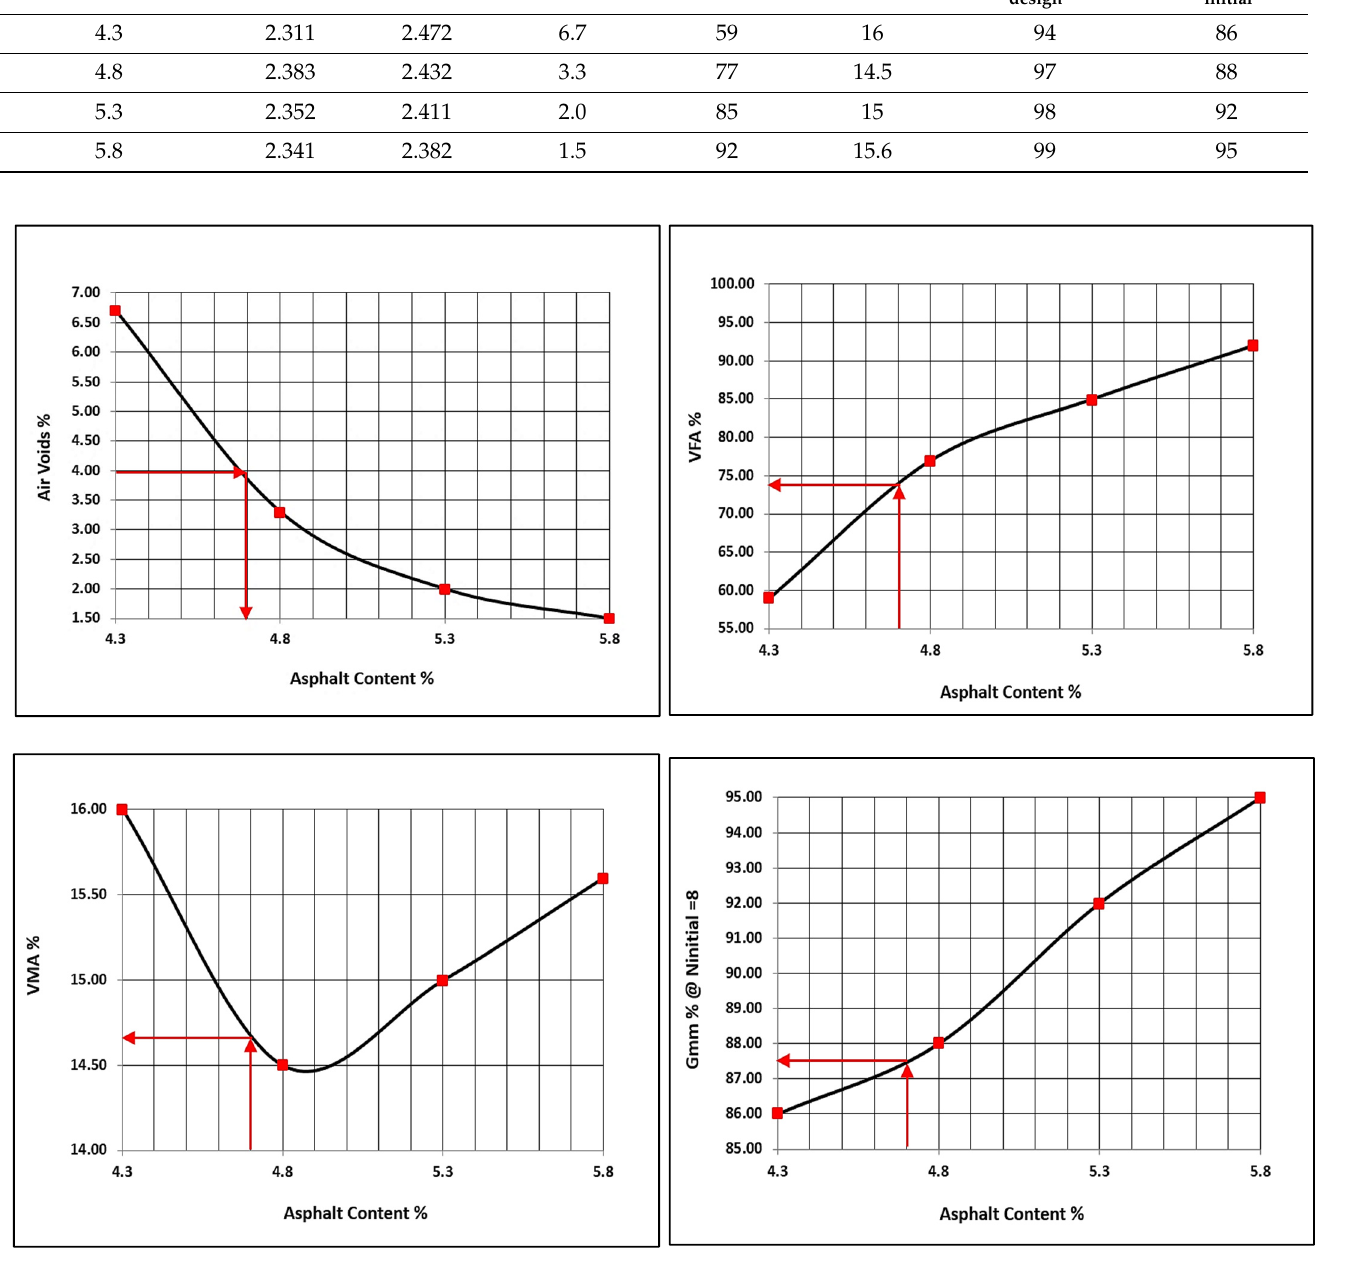
Figure 16. The volumetric properties of the trial WMA mixtures. The optimum binder content for the WMA mixtures is determined at 4.7%,